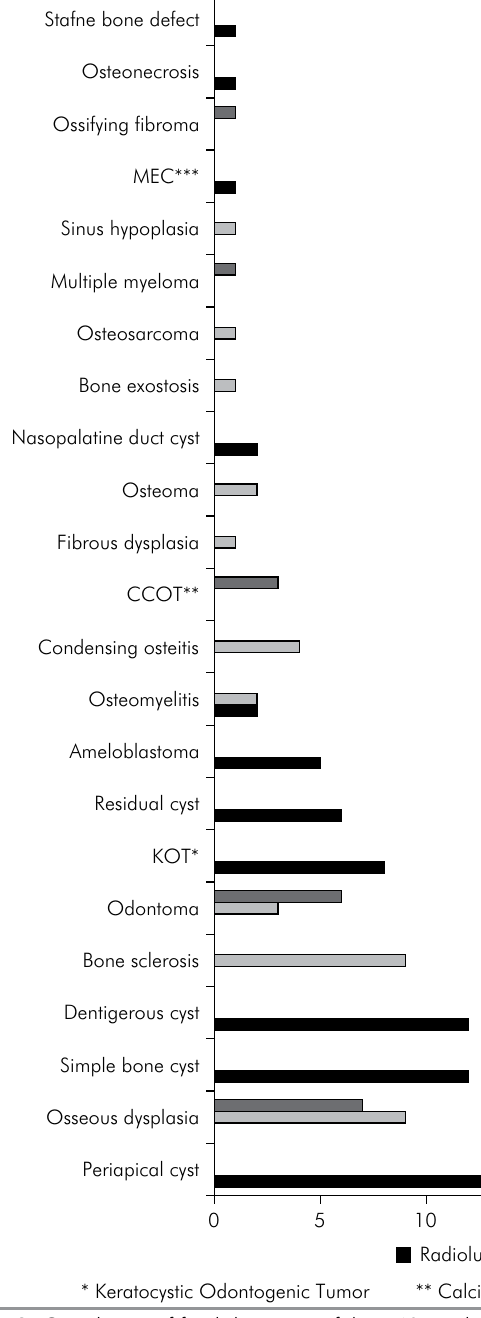
Figure 3. Correlation of final diagnosis of the 140 jaw lesions to radiographic